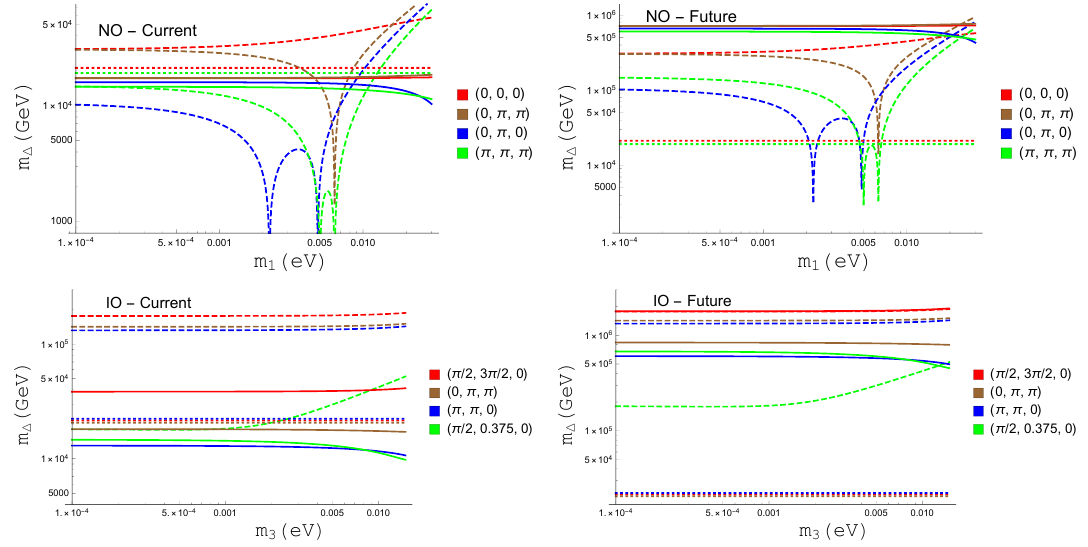
Figure 6 . Comparison plot of the maximum expected m ∆ probed by the µ → eγ (Dotted), µ → 3 e (Dashed), and µ to e conversion in Ti nuclei (Solid) processes for different sets of neutrino CP phases ( δ CP , α 21 , α 31 ) and varying lightest neutrino mass. The current (Left) and future expected sensitivity (Right) are depicted in both the NO (Top) and IO (Bottom) scenarios. All other parameters are given by the best fit parameters in table